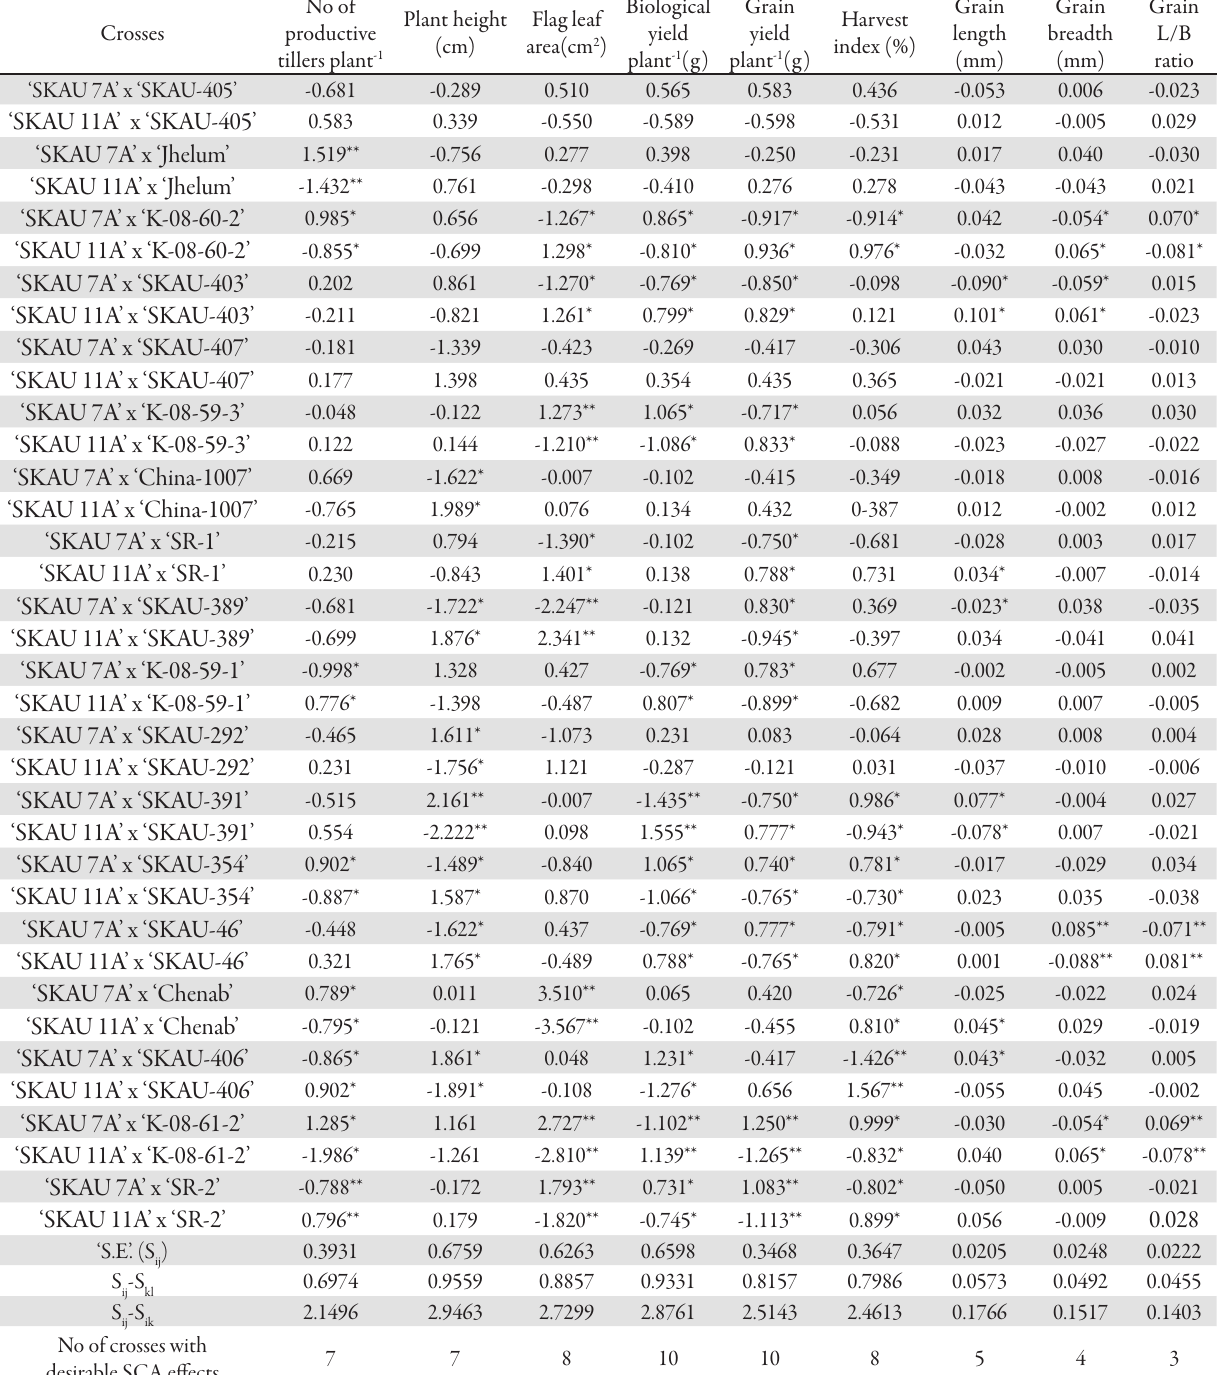
Tab. 6. Specific Combining Ability (SCA) effects of lines and testers for various agro-morphological traits in rice